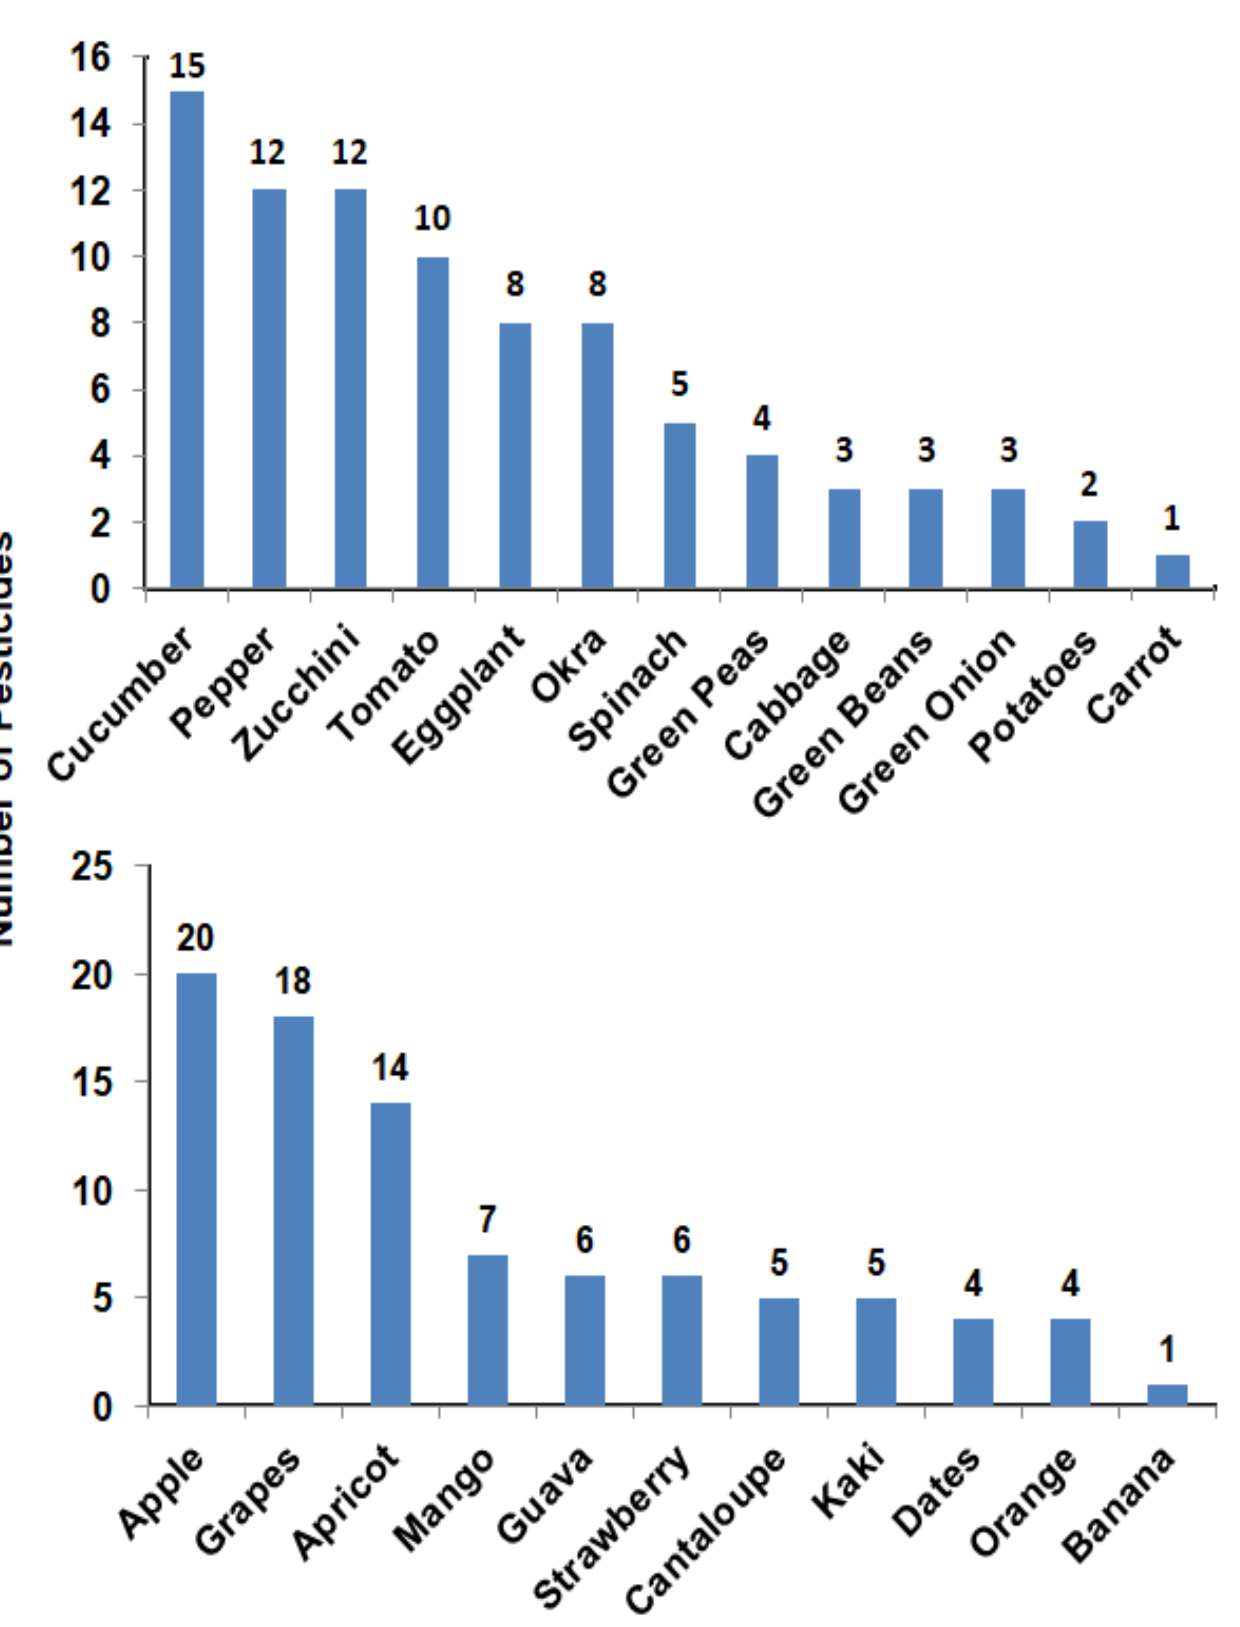
Figure 1. Number of pesticides detected in each vegetable ( upper ) or fruit ( lower ) sample.